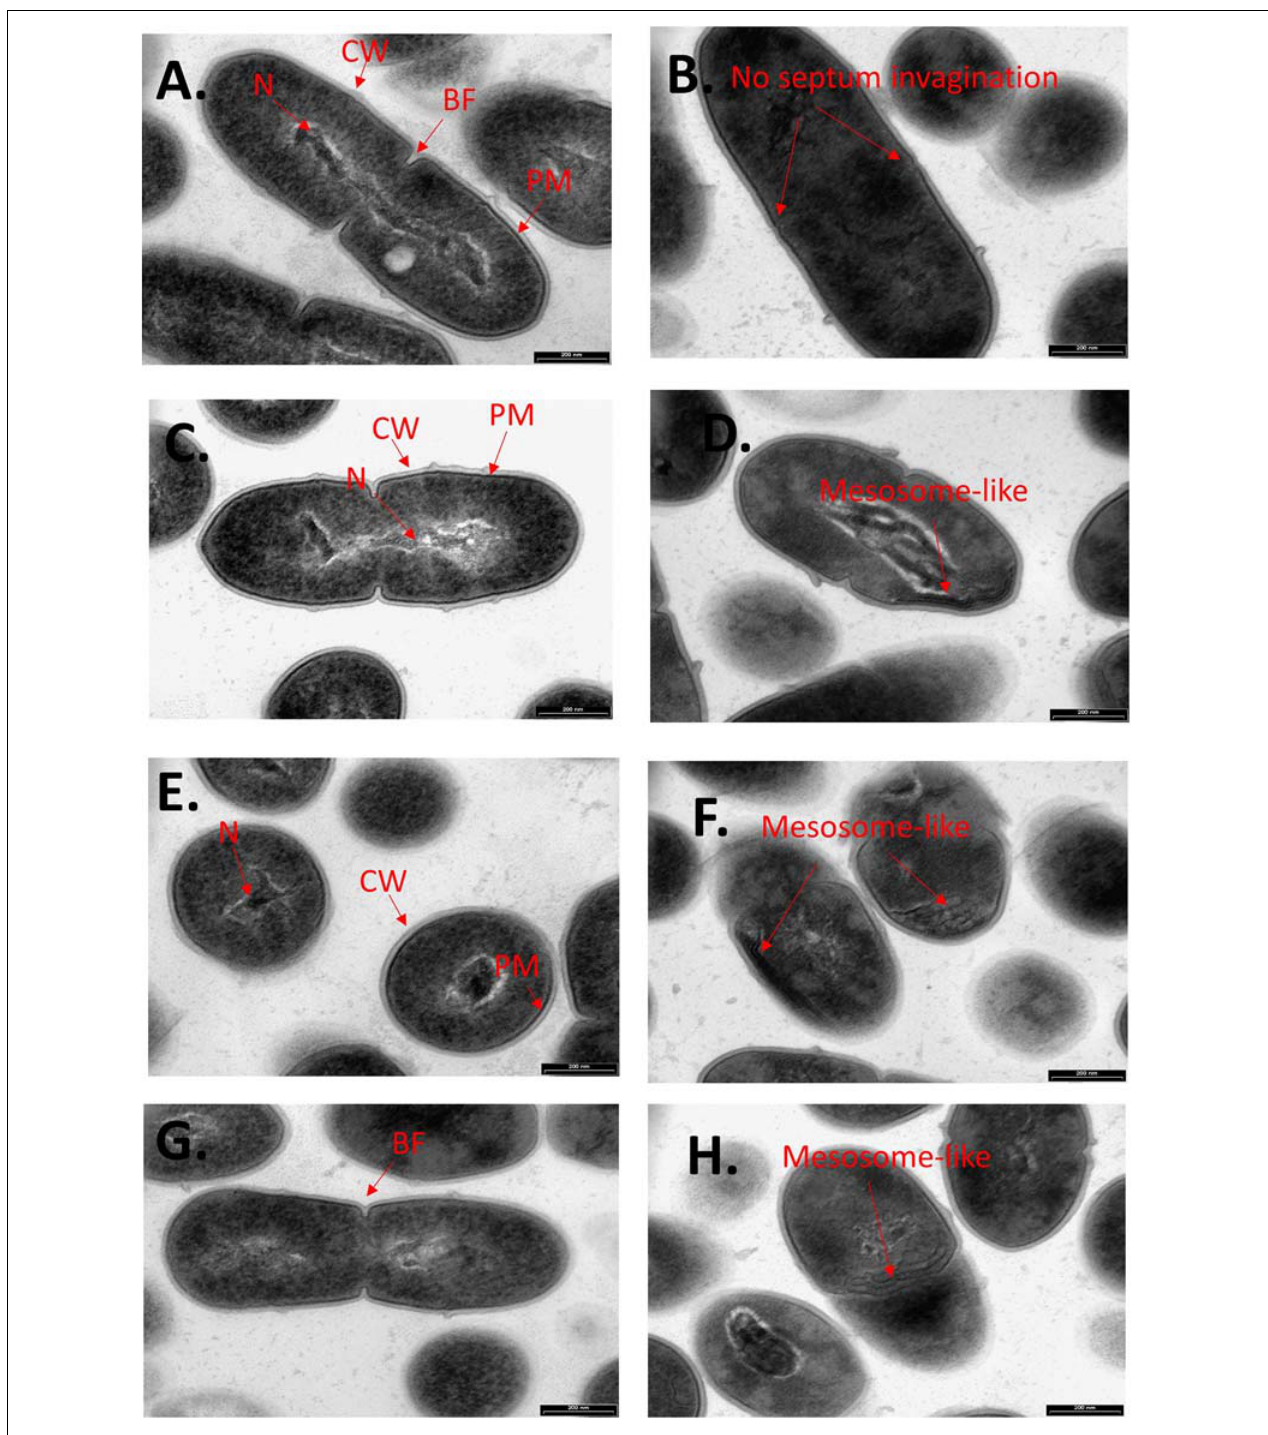
FIGURE 4 | CBG alters the morphology of S. mutans. Higher magnification TEM images (x59000) of control (A,C,E,G) and 4 h CBG (10 µ g/ml)-treated (B,D,F,H) S. mutans . The arrows show the cell wall (CW), cell membrane (PM), nucleus (N), the invagination septum (BF-Binary fission), and the mesosome-like structures.